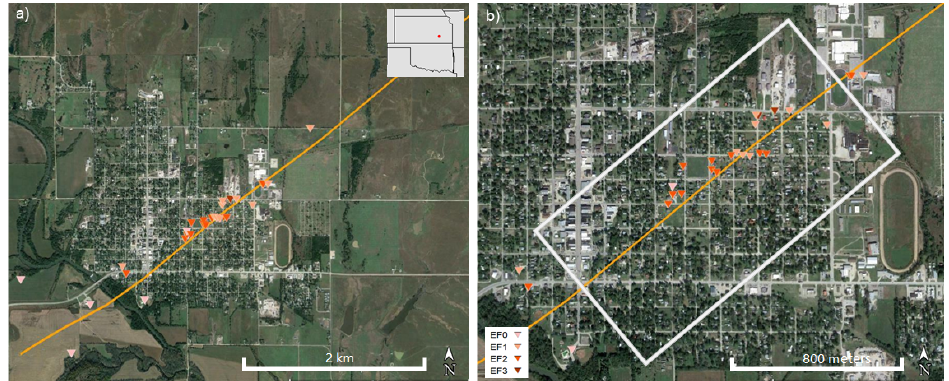
Figure 1. Kansas tornado, 26 June 2018 Eureka, ( a ) path overview and ( b ) survey site outlined in white box. Inverted triangles correspond to Enhanced Fujita (EF) scale ratings with the strongest damage (EF3) shown in dark red and weakest damage (EF0) shown in light pink were obtained from ground surveys conducted by the National Weather Service Weather Forecast Offices (NWS WFOs) Wichita,